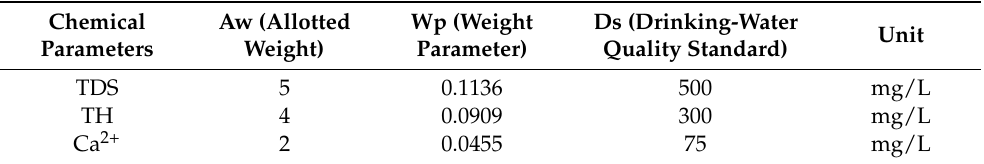
Figure 3. Technical roadmap of the traditional PIG method. Table 2. Values of allotted weight, weight parameter and drinking-water quality standard as well as the units of the 12 chemical parameters